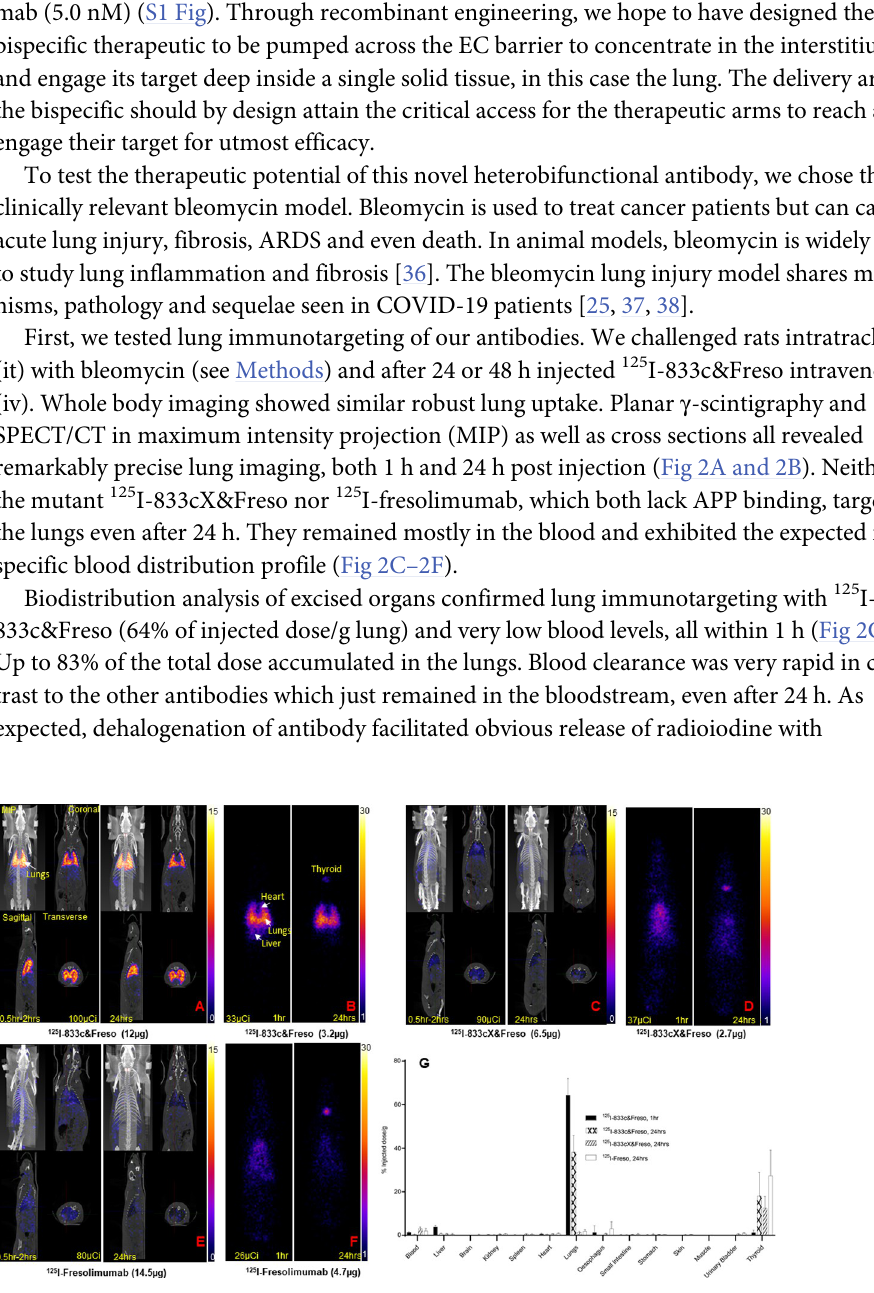
Fig 2. Lung targeting of 833c&Freso but not fresolimumab. After bleomycin treatment, rats were injected iv with radio-iodinated antibodies 125 I-833c&Freso, 125 I-833cX&Freso, and 125 I-fresolimumab (see Methods). (A, C, E) SPECT/CT images of rats taken at 1 � and 24 h. Maximum intensity projection (MIP), coronal, sagittal, and transverse cross sections are shown. (B, D, F) Planar F067-scintigraphy imaging at the indicated timepoints. A-F: N = 2–3 rats per group (G) Biodistribution analysis of radioiodinated antibodies. Radioactivity was counted in the indicated organs excised from bleomycin-exposed rats. Uptake was quantified as the percentage of injected dose per gram tissue (means ± SD). N = 3–10 rats per group. � Imaging started at 30 min and takes approximately 30 to 90